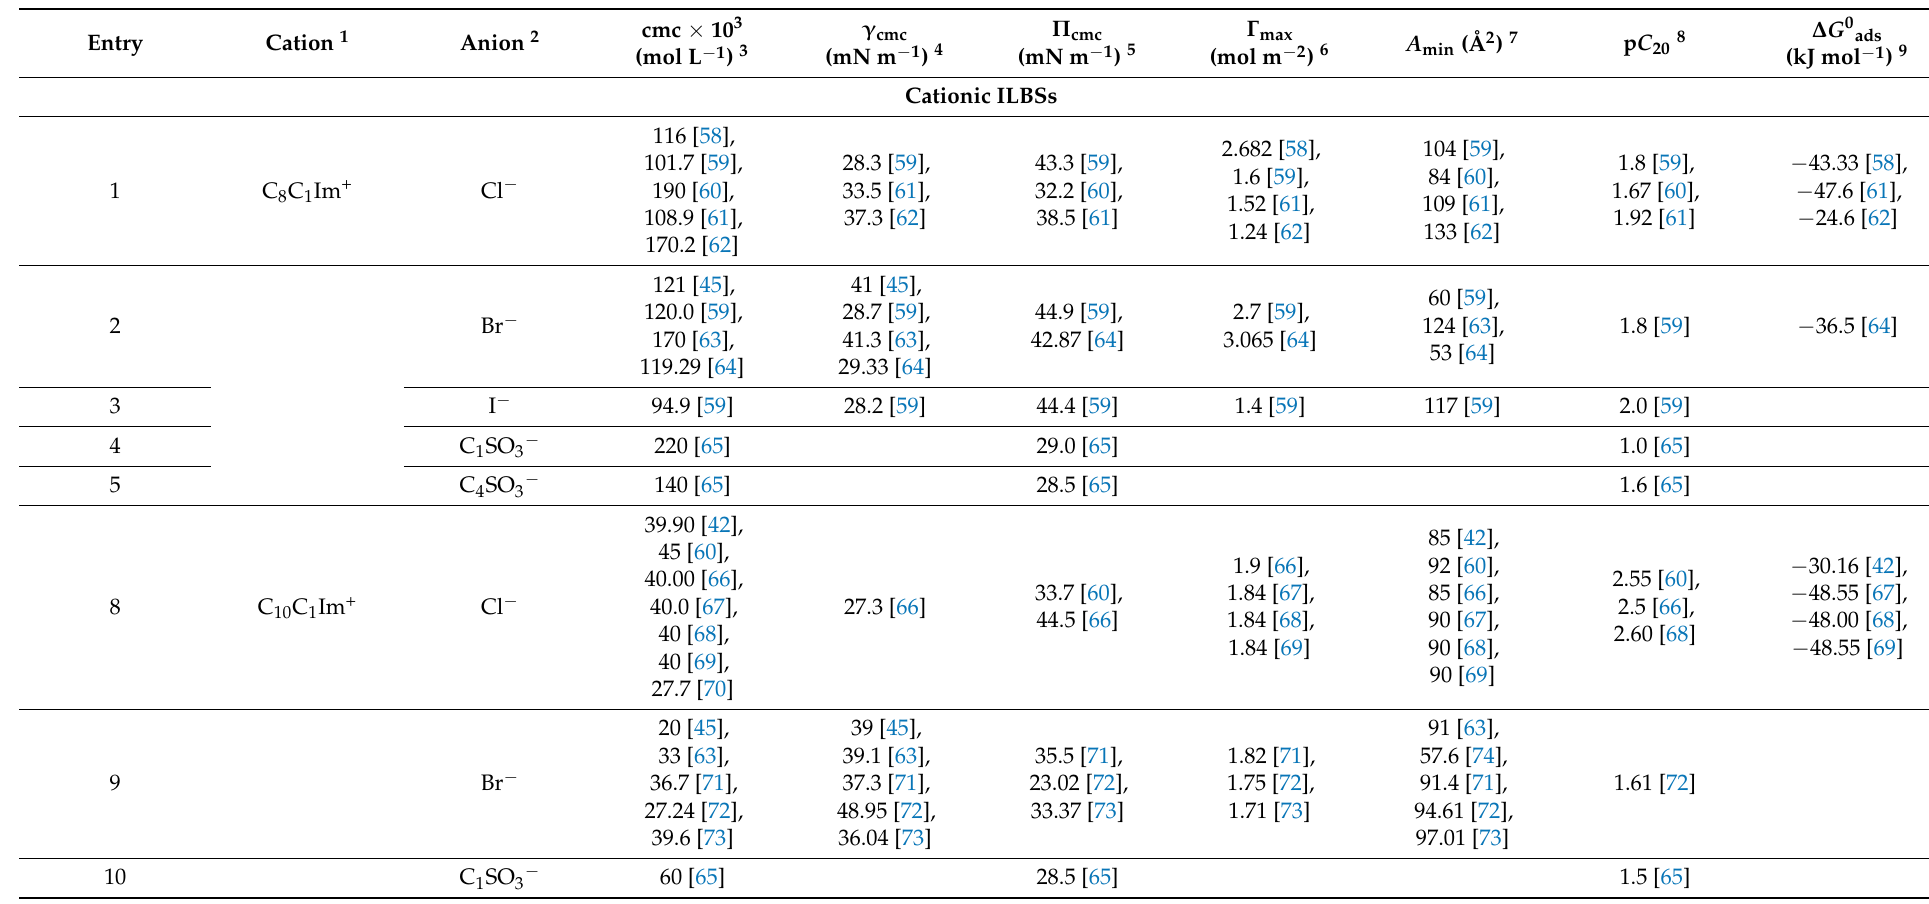
Table 1. Literature data on aqueous solutions of ionic liquid-based surfactants at 25 ◦ C. Adsorption and micellar parameters calculated from surface tension